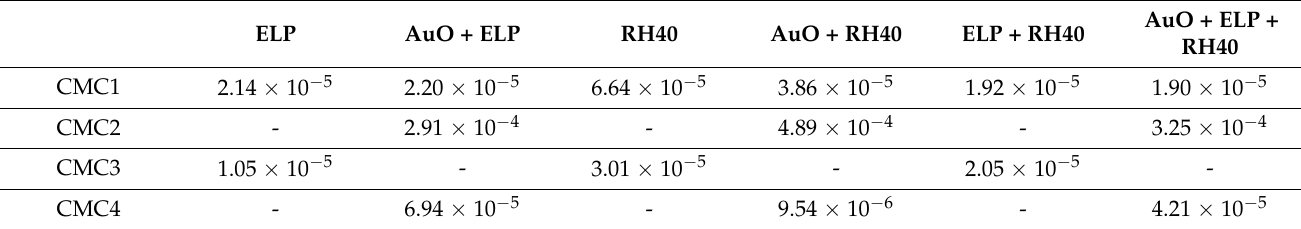
Table 3. The values of the CMC (mol/dm 3 ) of AuO, ELP, RH40 and their mixtures determined from the surface tension measurements (CMC1), AuO emission spectra (CMC2), pyrene emission spectra (CMC3) and density measurements (CMC4). The values of CMC1 for ELP, RH40 and ELP + RH40 are taken from Ref. [10] and CMC2 for ELP from Ref.